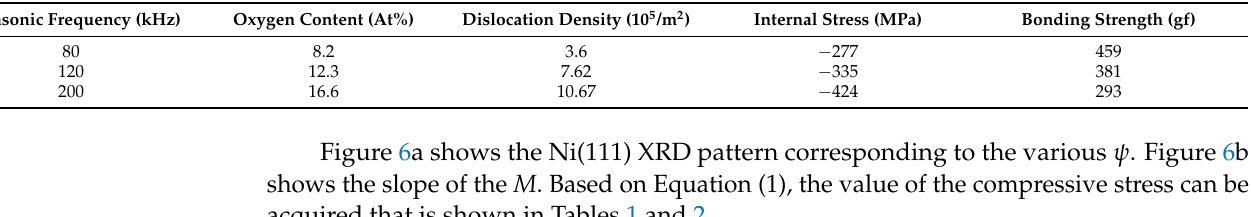
Figure 6. ( a ) Ni(111) XRD pattern corresponding to the various ψ (80 kHz, 100 W); ( b ) the slope of the M.